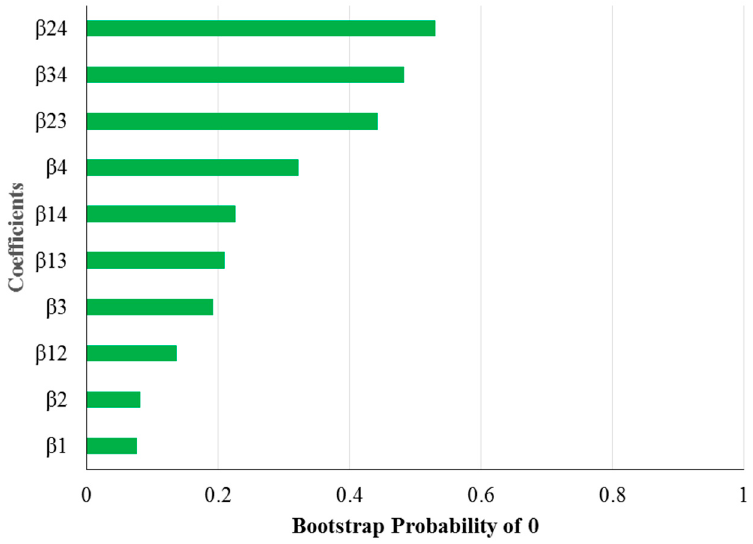
Figure 4. Ordering of (individual and interaction) effect sizes in terms of their bootstrap probability of zero for Manufacturer 1.